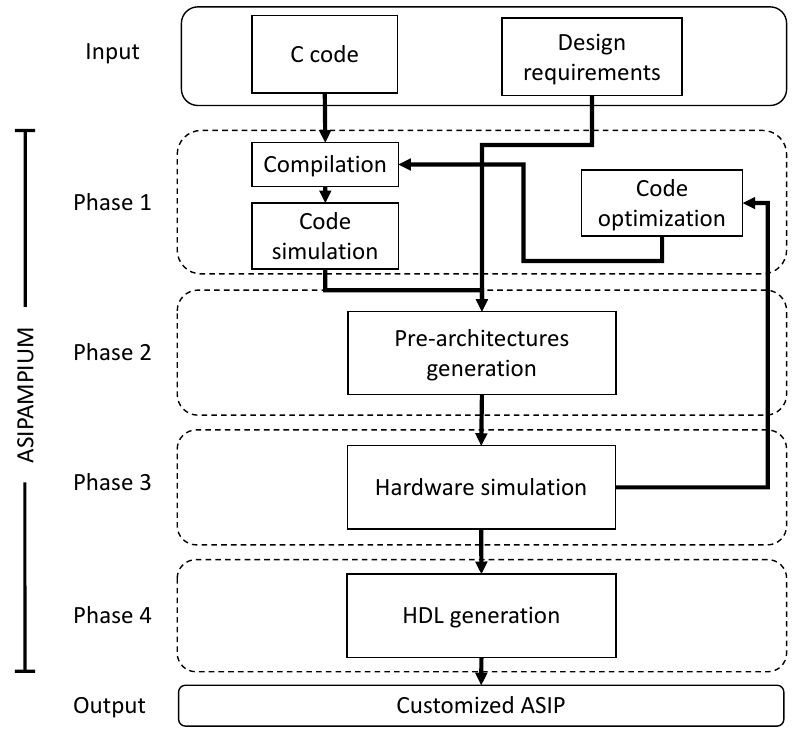
Figure 15. Design flow of the ASIPAMPIUM